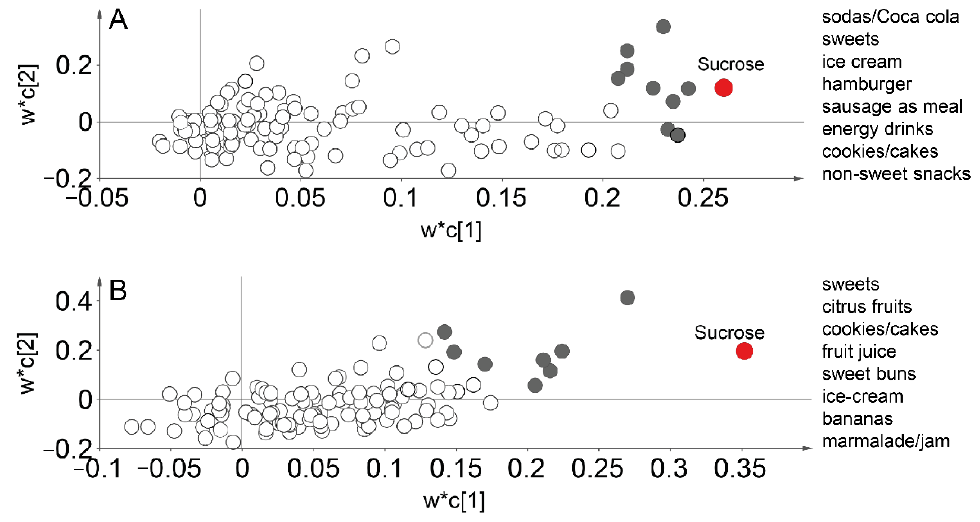
Figure 3. Loading plots from PLS regression to identify food intake and preferences associated with estimated daily sucrose intake (g/day). The upper figure ( A ) refers to the younger group and the lower figure ( B ) to the older group. Red dots represent the dependent variable and grey dots foods significantly influential for the variation of the dependent variable. Unfilled circles indicate non-influential food intakes and preferences. The models were strong with an explanatory power (R 2 ) of 0.92 and 0.87 and a cross-validated predictive power (Q 2 ) of 0.78 and 0.62 for the two groups ( A , B ), respectively. w*c refers to the X loading weight (w), and Y loading weight (c) combined to one vector showing the relationships between X and Y, for component [1] and component [2].